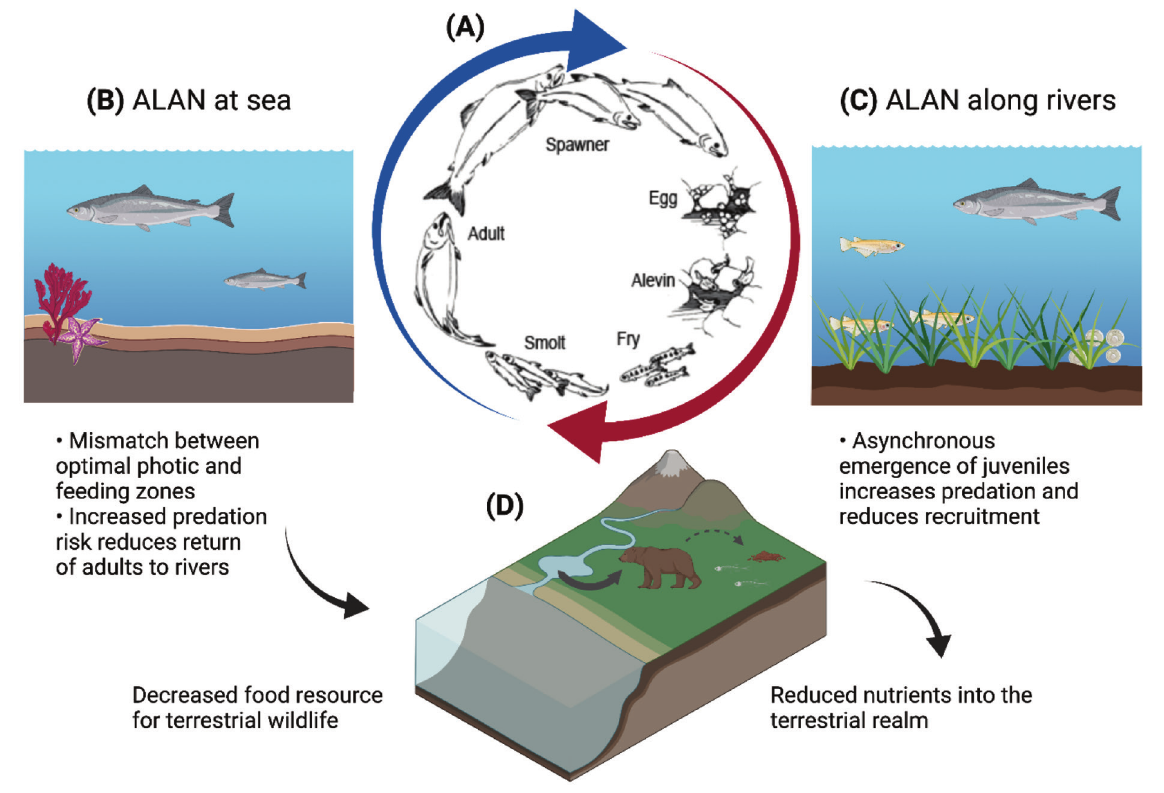
Schematic figure showing the potential cross-realm impacts of ALAN due to effects on different life stages in salmon. (A) Salmon spend their juvenile phase in rivers before migrating to sea to grow and mature. To complete their life cycle, they must return to the river to spawn. (B) ALAN at sea alters vertical movement of fish resulting in a mismatch between preferred light levels and optimal feeding zones. Additionally, ALAN results in increased predation of fish at sea and hence a decrease in adults returning to rivers. (C) ALAN along rivers disrupts synchronous emergence of juveniles resulting in increased predation which then reduces the recruitment of smolts out to sea. This reduction in adults returning to rivers and smolts migrating to sea results in trophic effects in both realms. (D) Illustrates one trophic effect in the terrestrial environment with reduced food resources for bears resulting in reduced nutrients into the terrestrial environment. Image created with